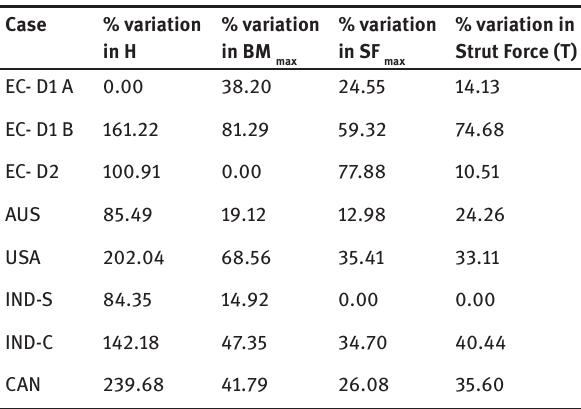
Table 11: Relative percentage increase of